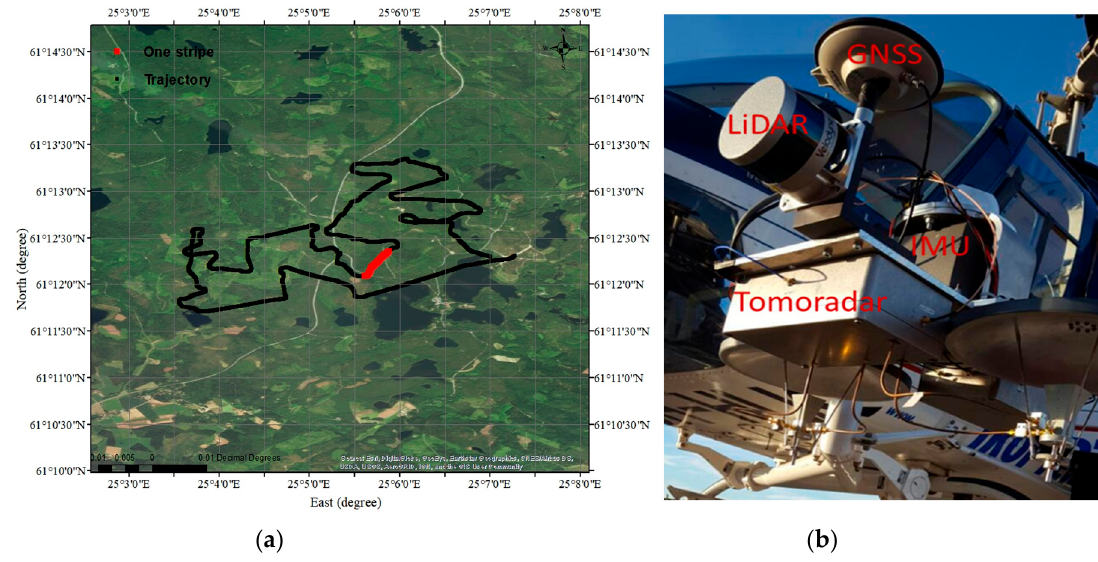
Figure 1. ( a ) Trajectory diagram in the west section of study area (black line), and a route of investigated data in one stripe (red line); and ( b ) the configurations of the instruments on the Bell 206 helicopter: Tomoradar, LiDAR, and GNSS-IMU.